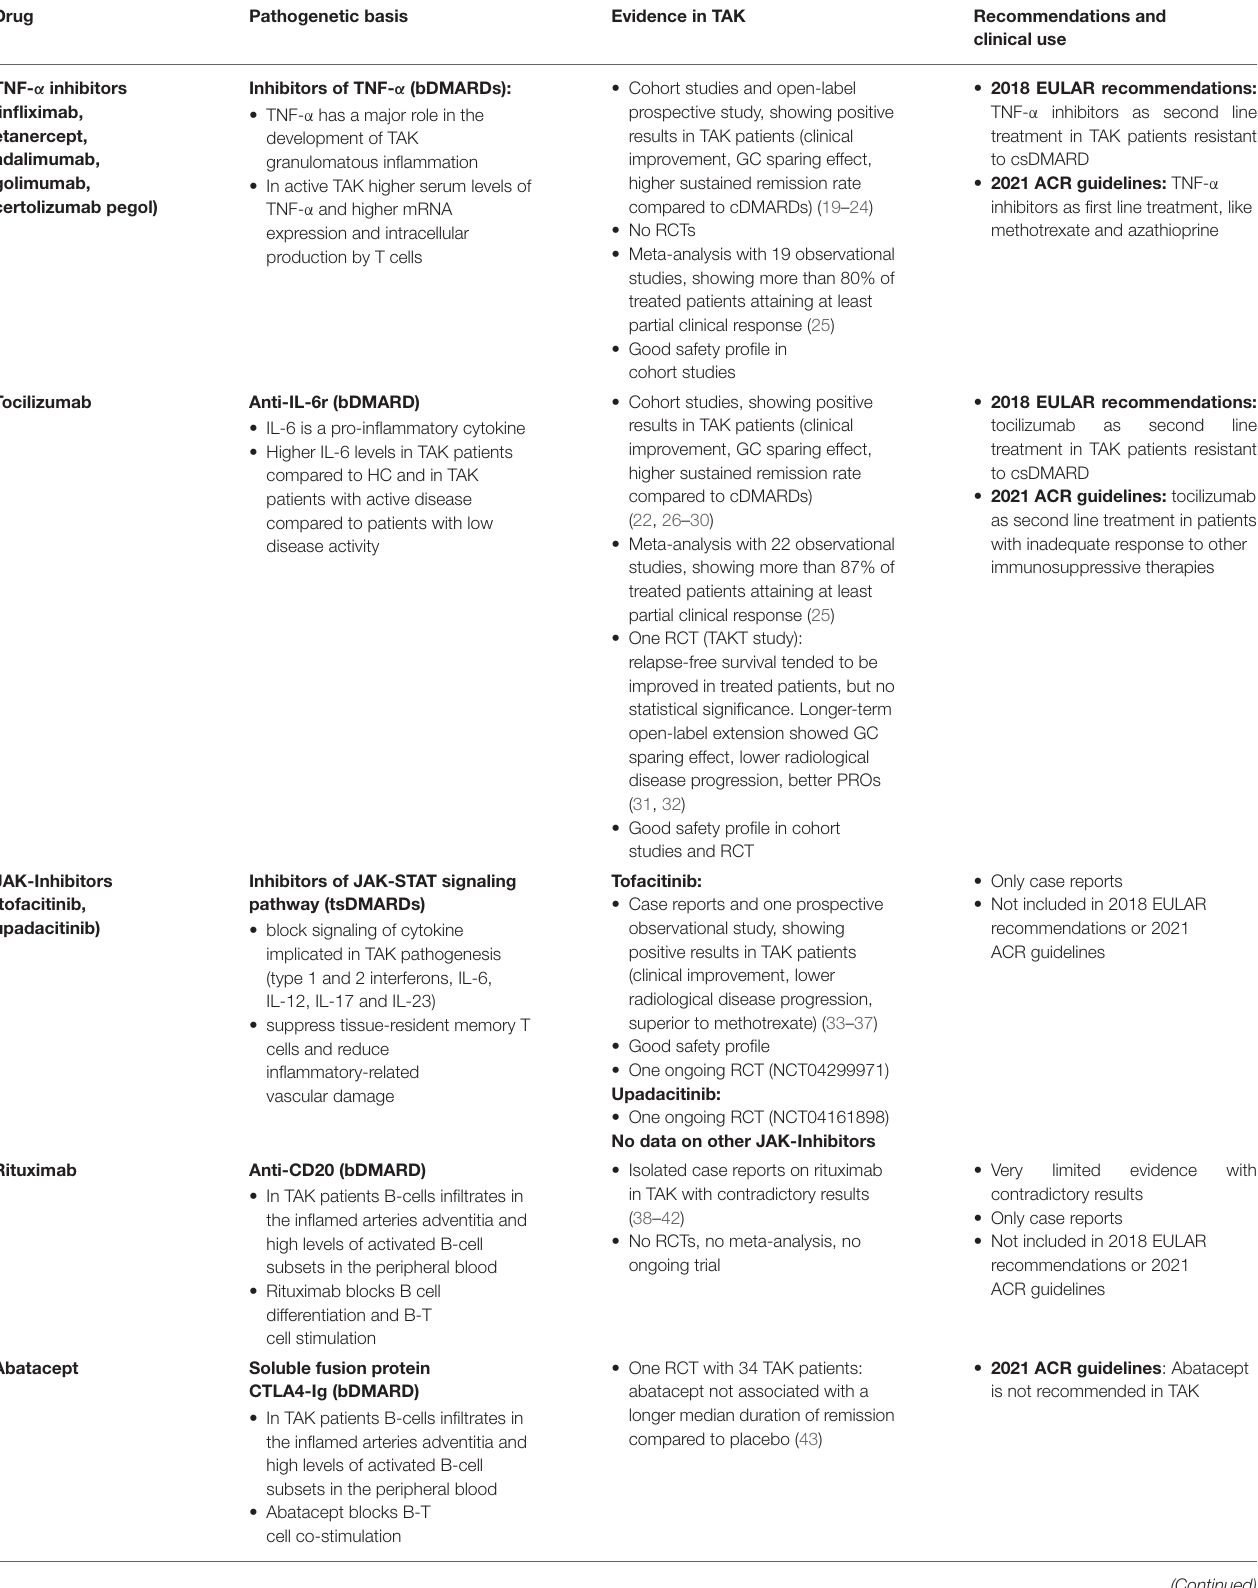
TABLE 1 | New targeted therapies in Takayasu